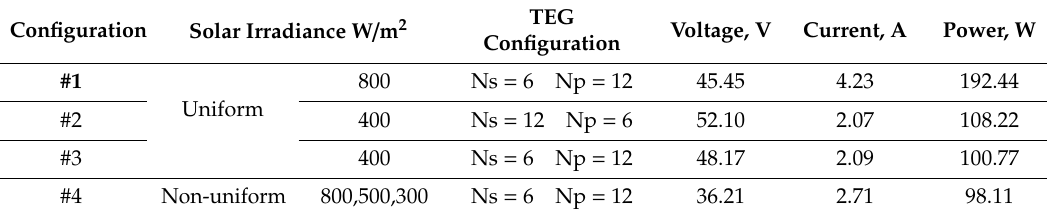
Table 6. Voltage, current and power at MPP under different configurations and conditions of PVTEG system.